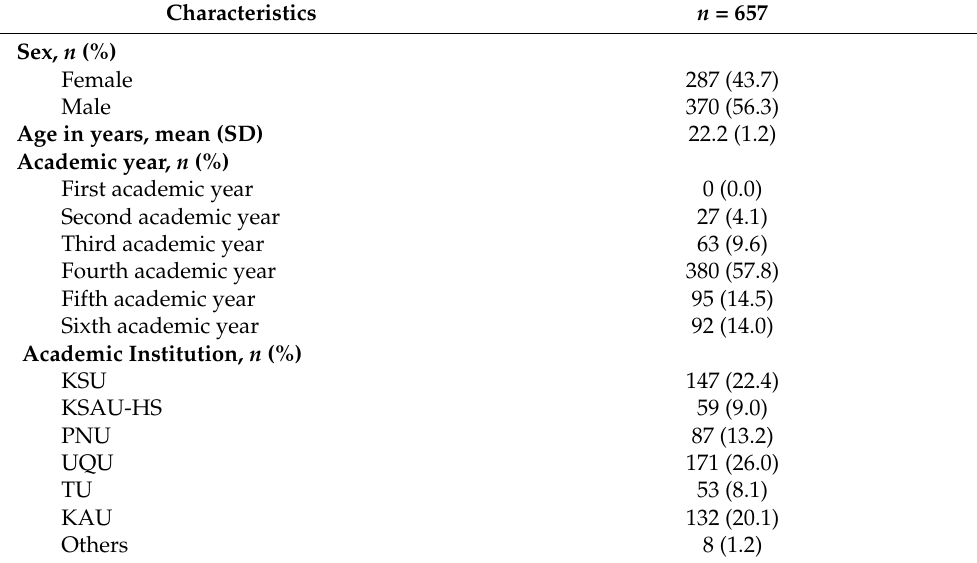
Table 1. Included student